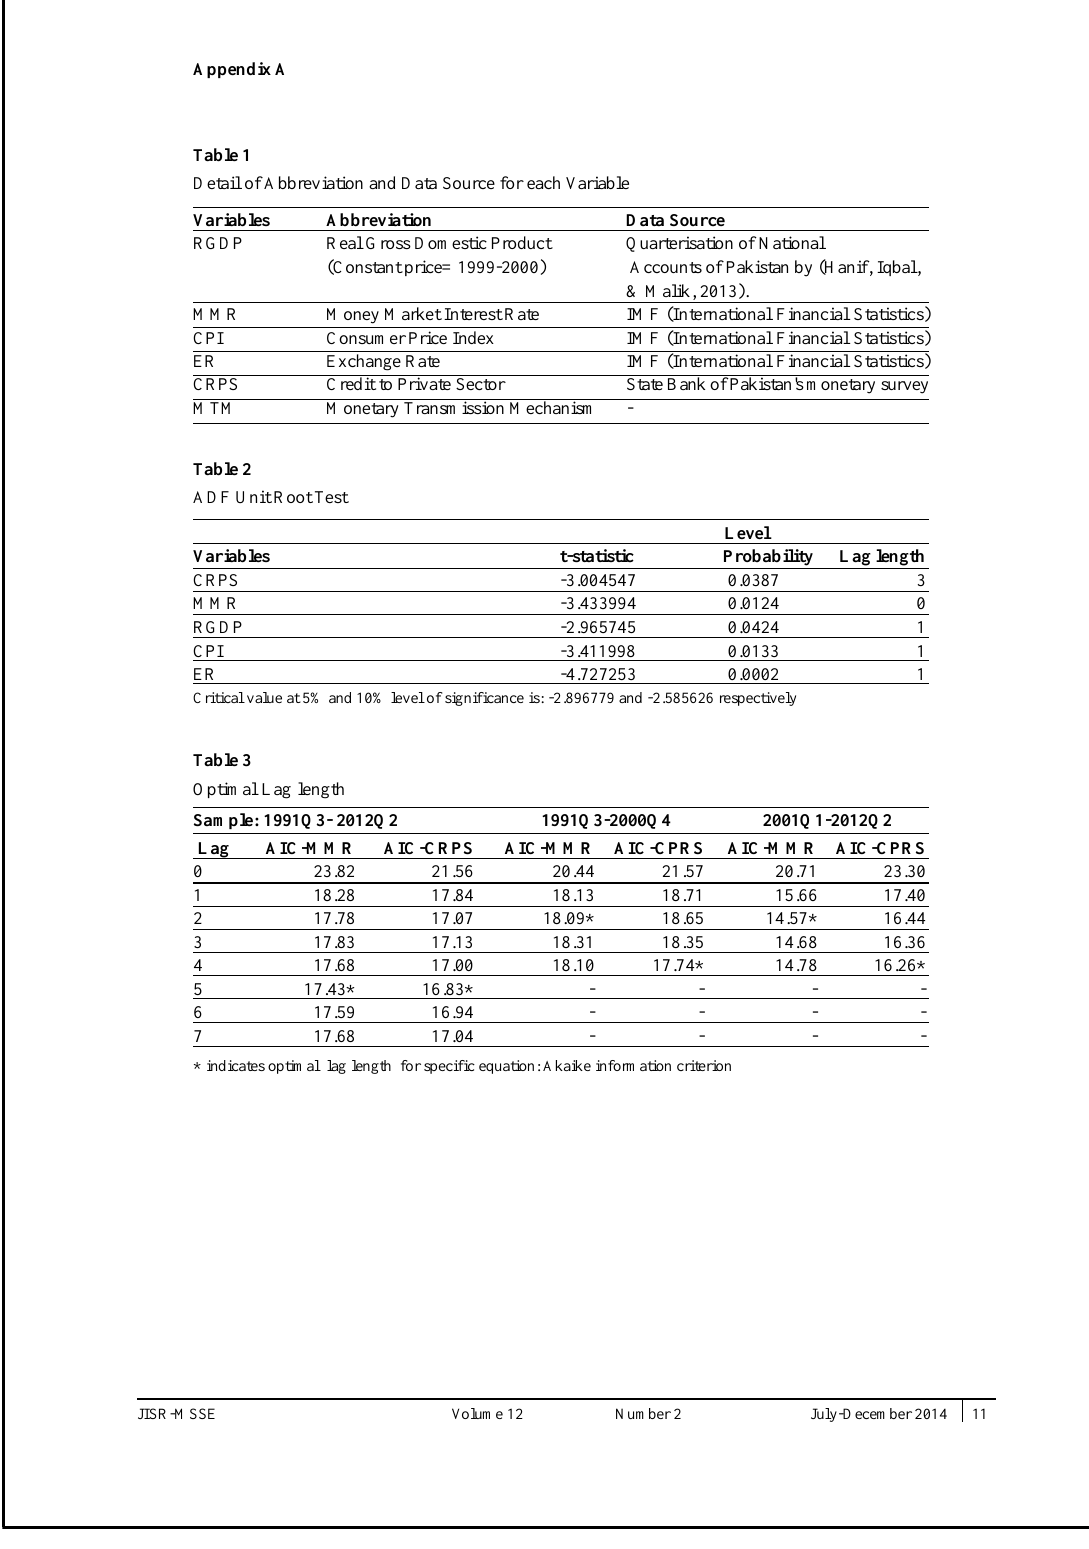
Detail of Abbreviation and Data Source for each Variable